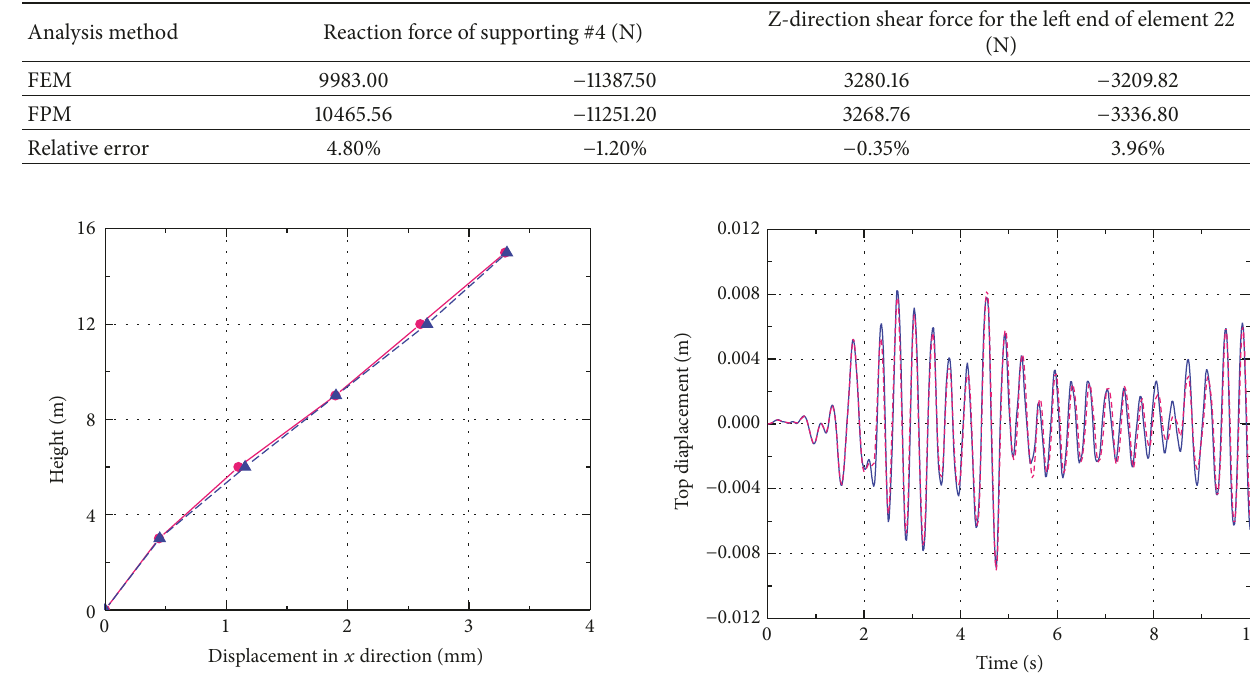
Table 3: Partial internal force extreme values.